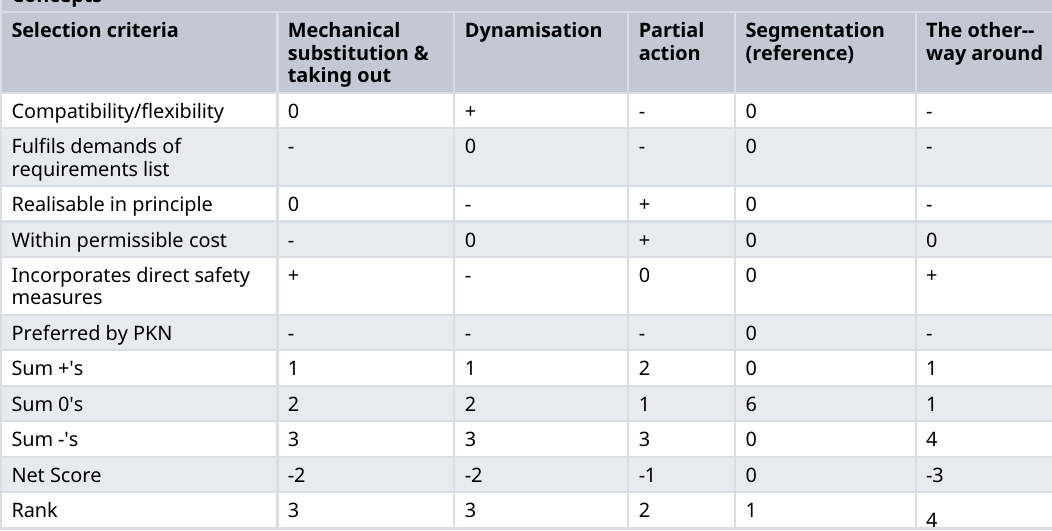
Table 4. The concept generation process in this research used a four-step method inspired by Karl and Steven: 114